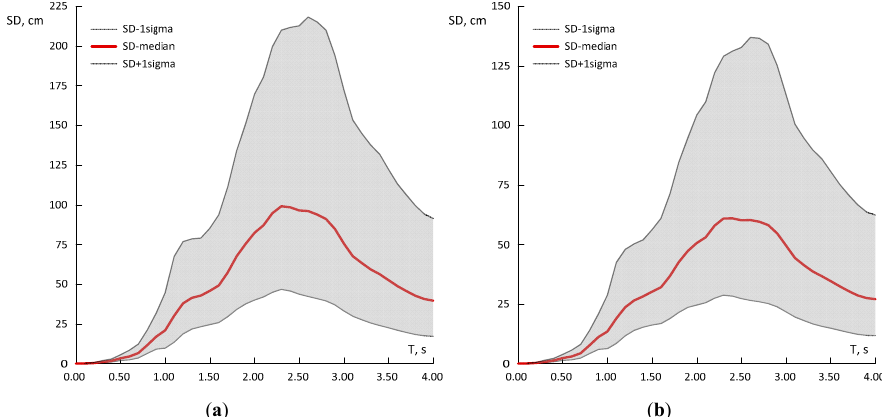
Figure 11. Predicted displacement spectra for a M W = 7.5 seismic event type C soil, with quadratic term ( a ) 100 km epicentral distance; ( b ) 150 km epicentral distance.